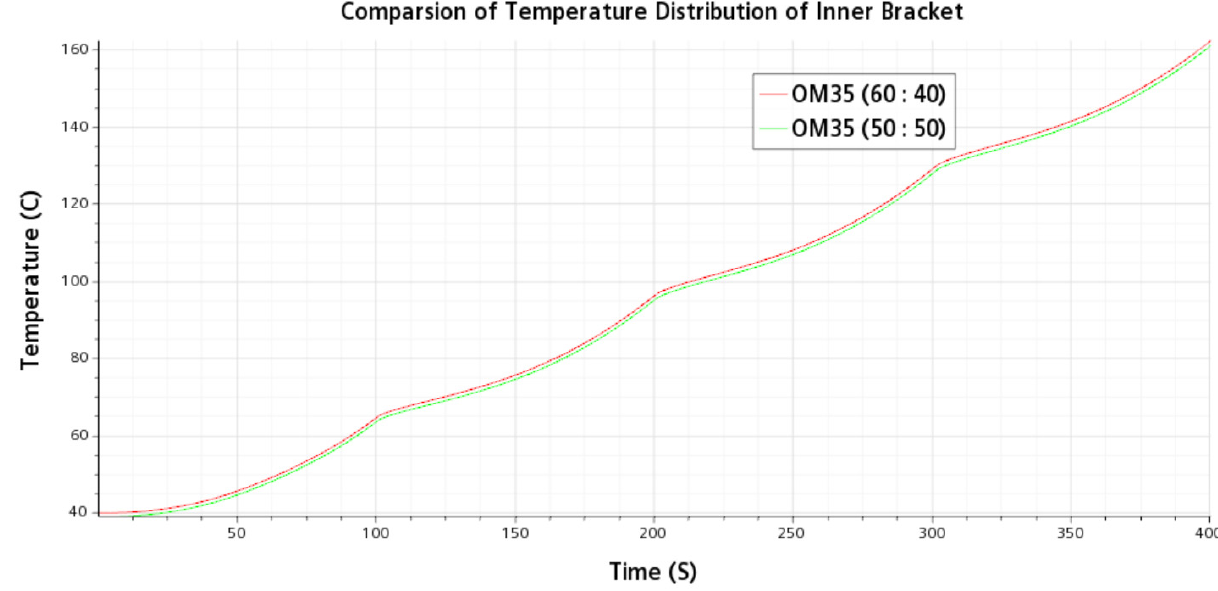
Figure 20. Comparison of temperature distribution of inner bracket plot over time for different PCM materials.